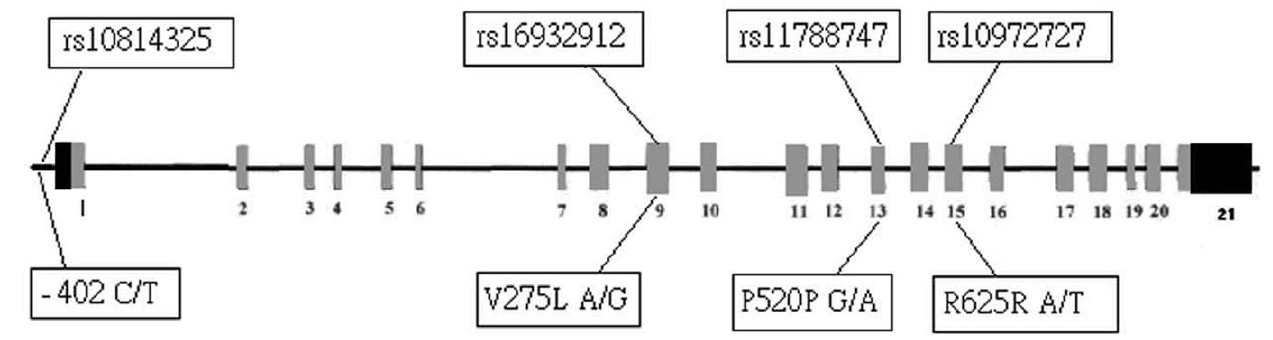
Figure 1. The location of human RECK gene single-nucleotide polymorphisms (SNPs) and functional amino acid.